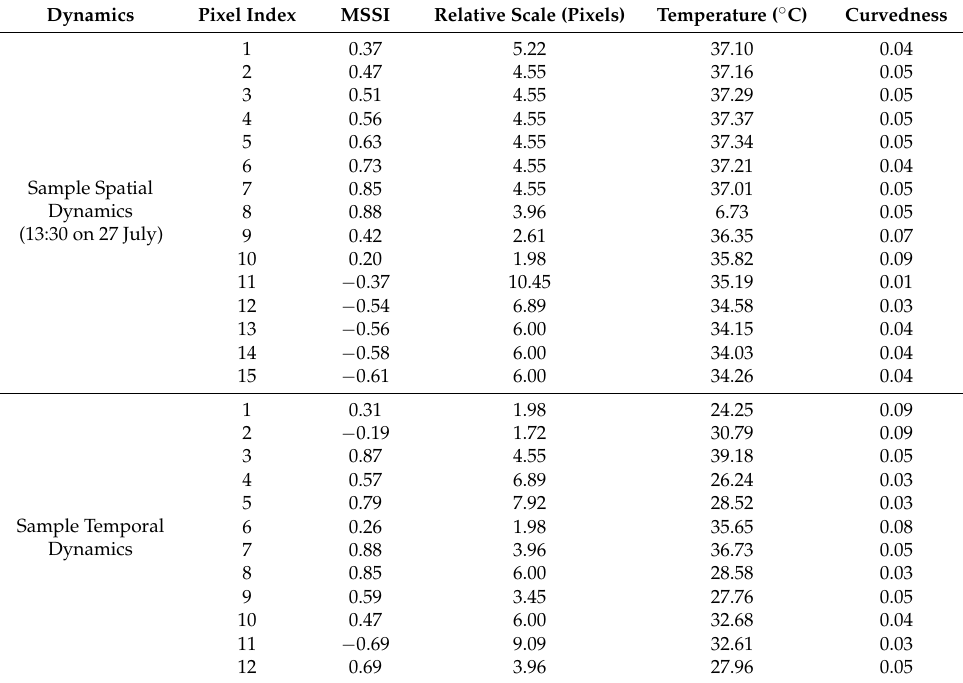
Table 3. The spatial and temporal dynamics of